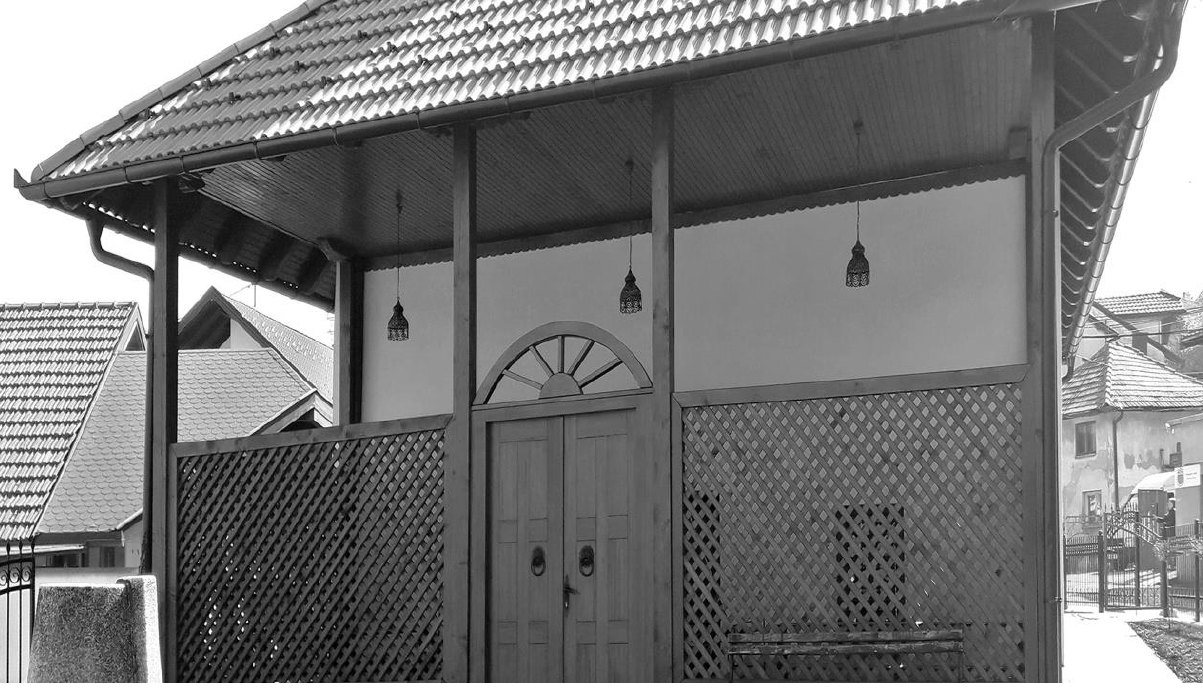
Figure 7. Front façade after the renovation (Photo by the